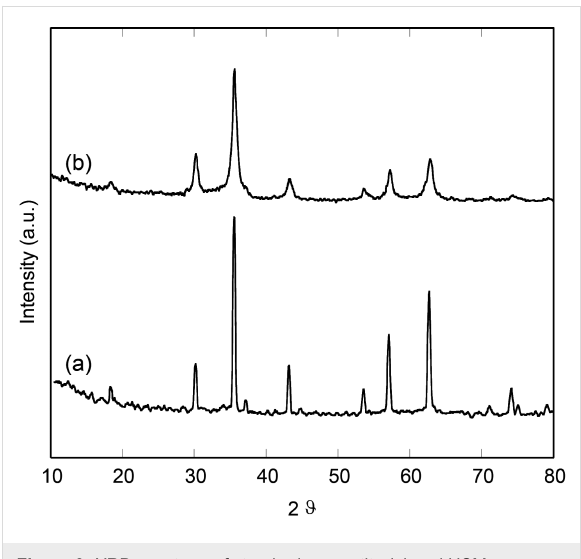
The USM sample readily responds to an external magnet and the main magnetic parameters, as derived by SQUID magne- tometry characterisation, are summarised in Table 1. ZFC-FC magnetisation curves indicate that the USM nanoparticles ex- hibit a superparamagnetic behaviour and that most of the parti- cles are blocked at room temperature, the blocking and maximum temperatures being out of the investigated range. The saturation magnetisation ( M sat ) as obtained from the hysteresis curve collected at 5 K was measured to be around 72 emu·g − 1 which is close to the value of bulk magnetite and maghemite